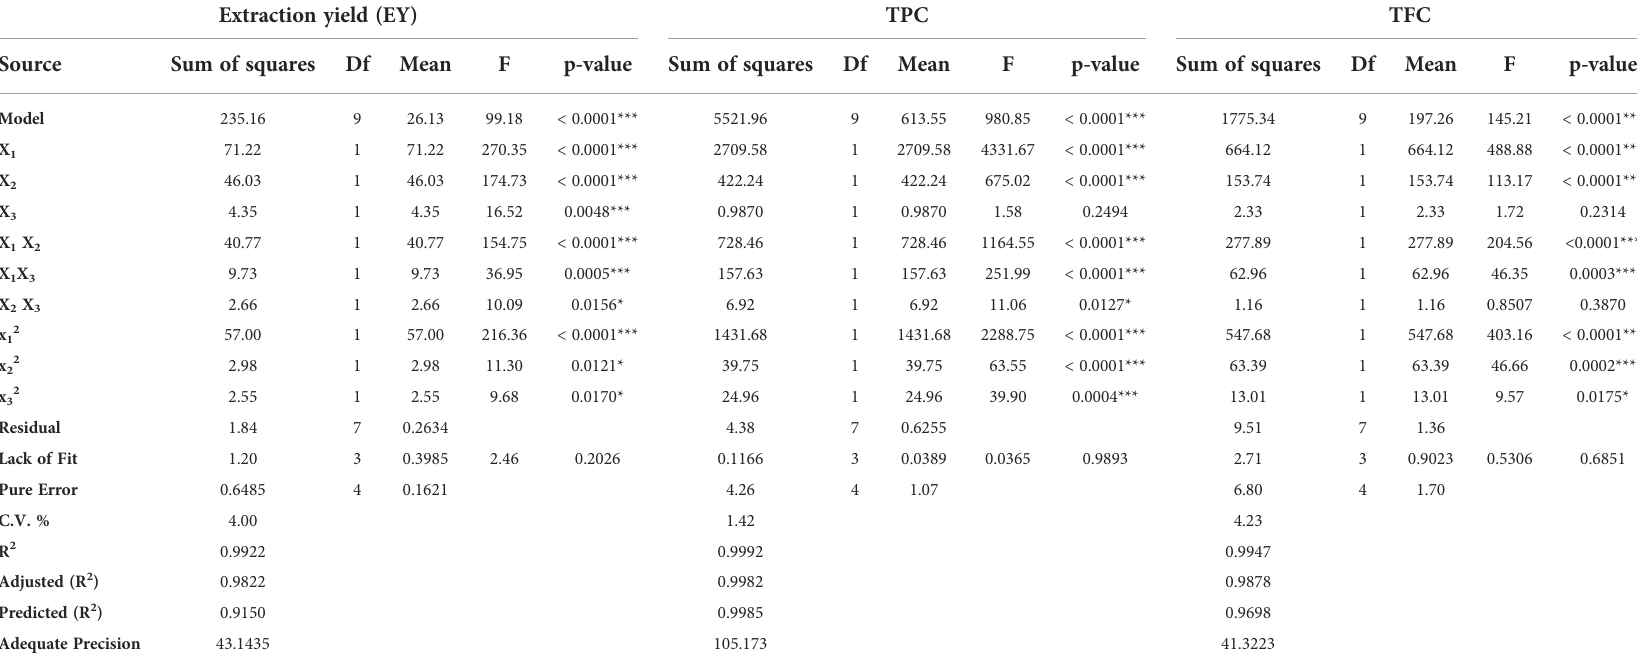
TABLE 3 ANOVA applied on obtained data for signi fi cance and suitability of design and different